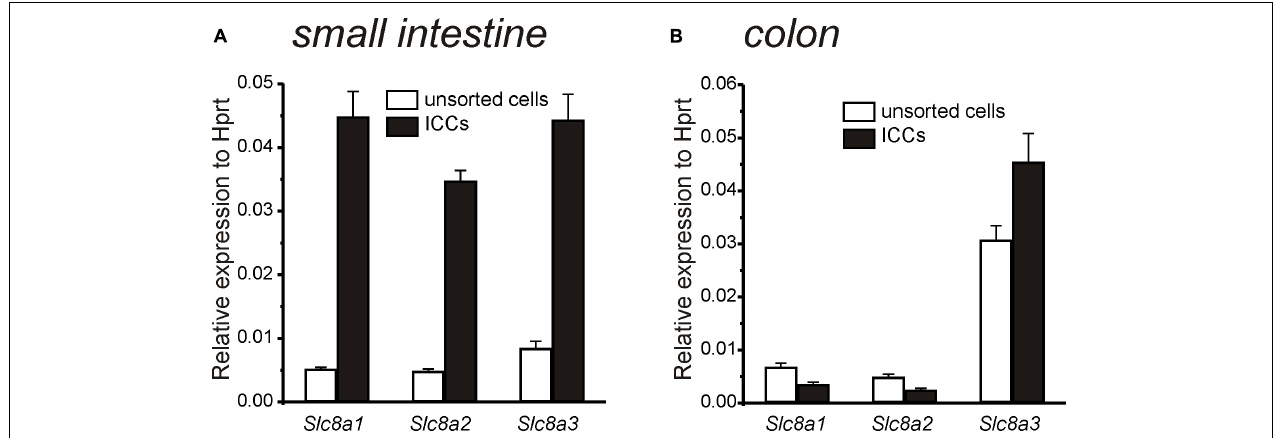
FIGURE 1 | Quantitative analysis of Na + -Ca 2 + exchanger ( Slc8a1-3 ) expression in ICC and unsorted cells from small intestine and colon. (A) Summary graph showing relative expression of Slc8a1, Slc8a2, and Slc8a3 in small intestinal ICC and in unsorted intestinal cells. Note greatly increased expression of all three isoforms in ICC of small intestine relative to the unsorted cells. (B) Summary graph showing relative expression of Slc8a1, Slc8a2, and Slc8a3 in colon ICC and in unsorted colon cells. Only Slc8a3 was elevated in colonic ICC. Expression of all transcripts was normalized to Hprt .